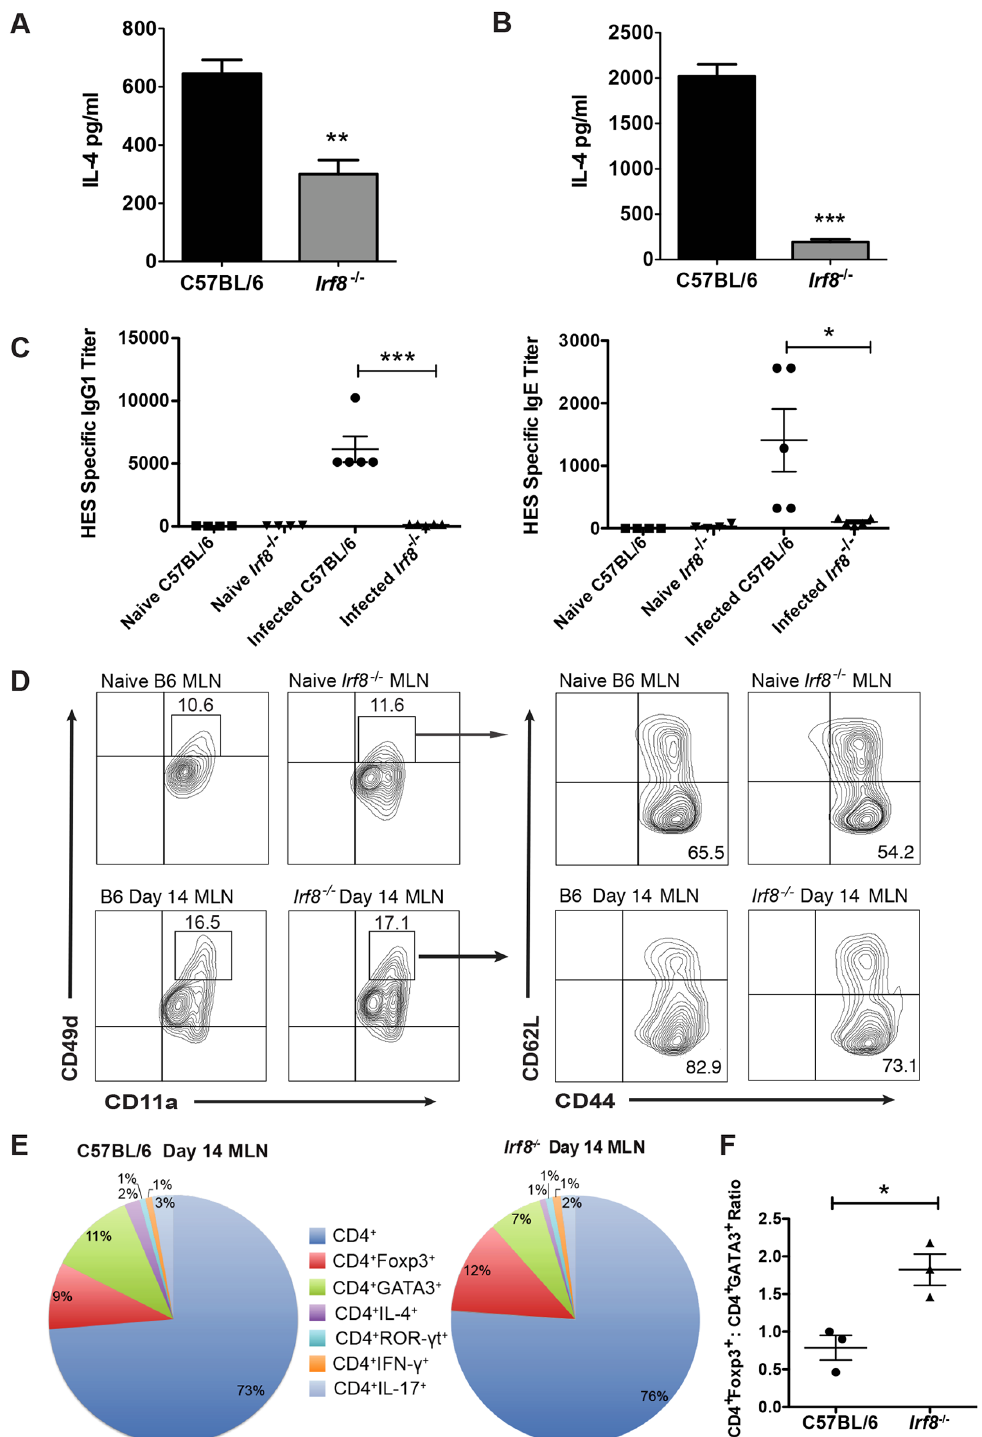
Fig 3. Analysis of CD4 + Th2 cell effector function in Hpb-infected C57BL/6 and Irf8 -/- mice. (A) MLN and (B) spleencells obtainedfrom C57BL/6(B6) and Irf8 -/- mice (n = 5 mice per group) on day 14 p.i. were stimulatedex vivo with 50 μ g AWH. Supernatants were collected48 h later and IL-4 levels determined by ELISA. Data representative of two to three replicateexperiments are presentedas mean ± SEM. ** ; p (cid:20) 0.01; *** , p (cid:20) 0.001. (C) HES-specific IgG1 and IgE titers in the sera of na ï veand infected B6 and Irf8 -/- mice on day 14 p.i. Each point